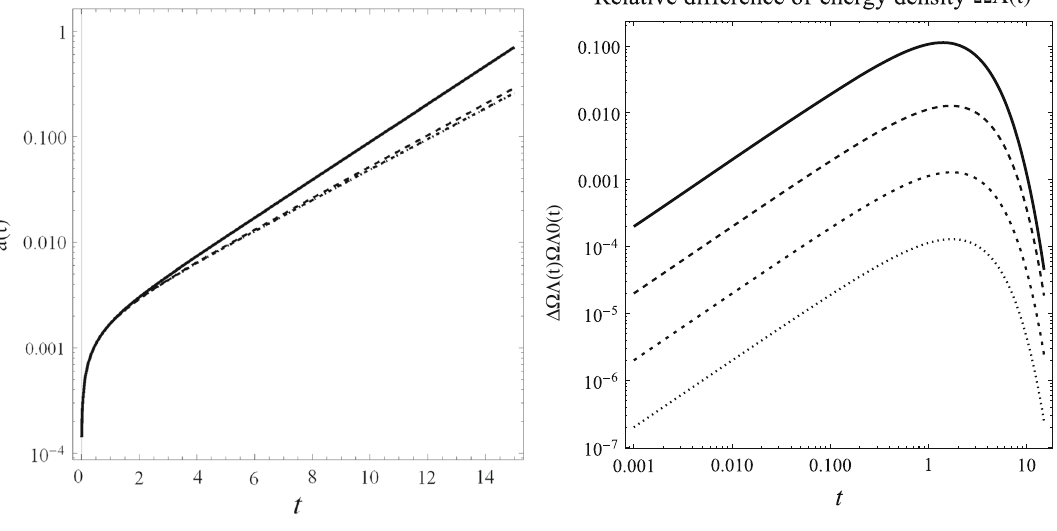
Fig. 5 Qualitative evolution in time for the scale factor a ( t ) (left fig- ure) and the relative difference of the energy density (cid:9) (cid:2) ( t ) for the solutions which were presented in Fig. 4. For the numerical integration we have considered λ 2 = 1, n = − 1, while the solid line provides